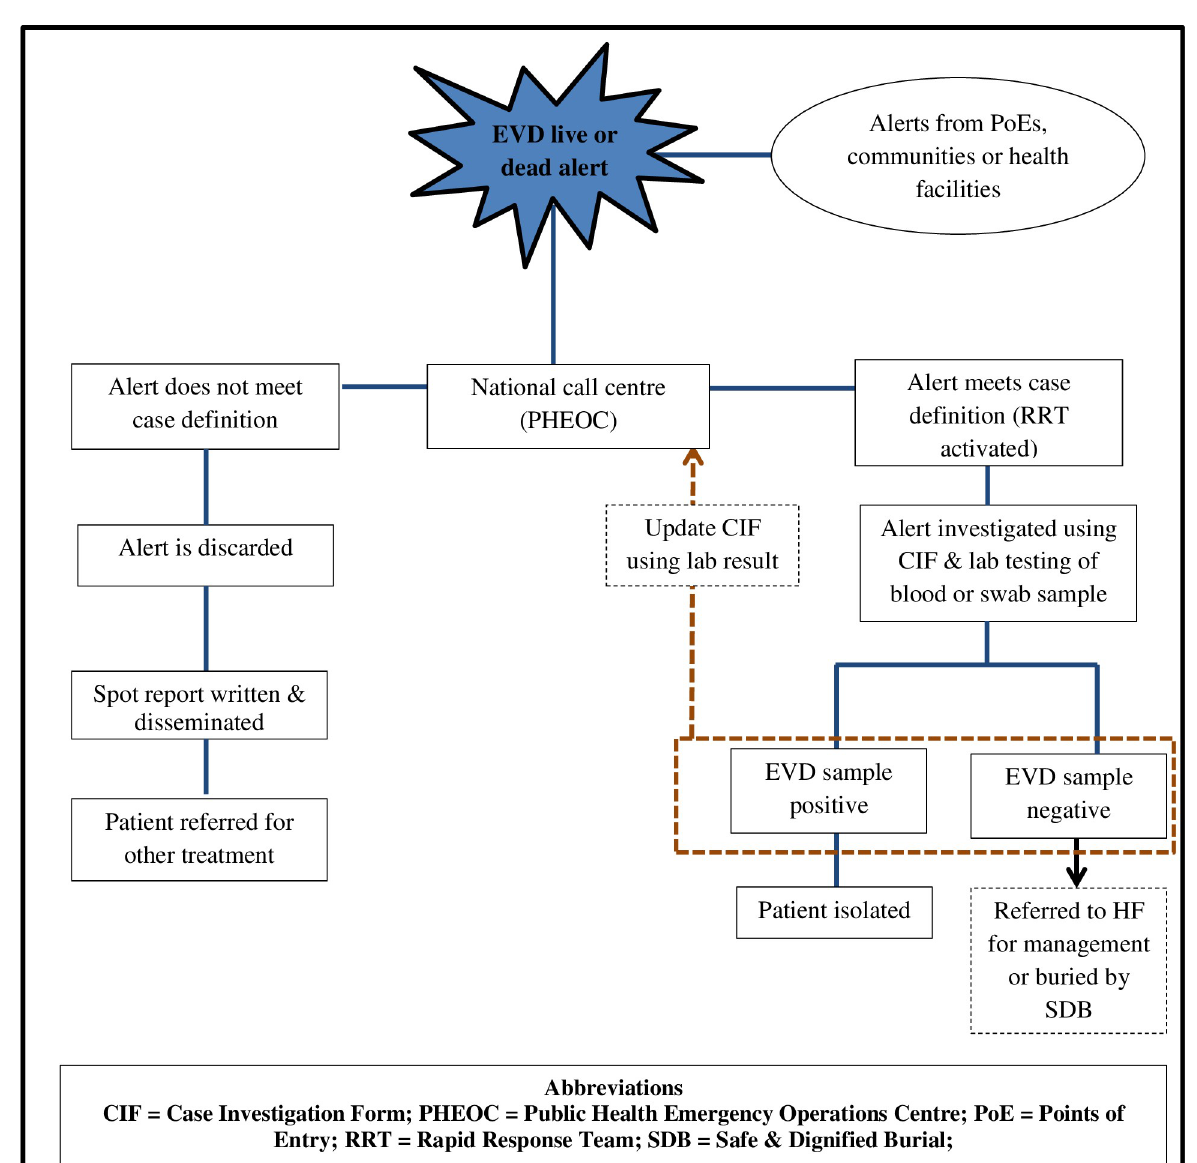
Fig 1. Algorithm for Ebola Virus Disease alert management system in South Sudan–August 2018 to November